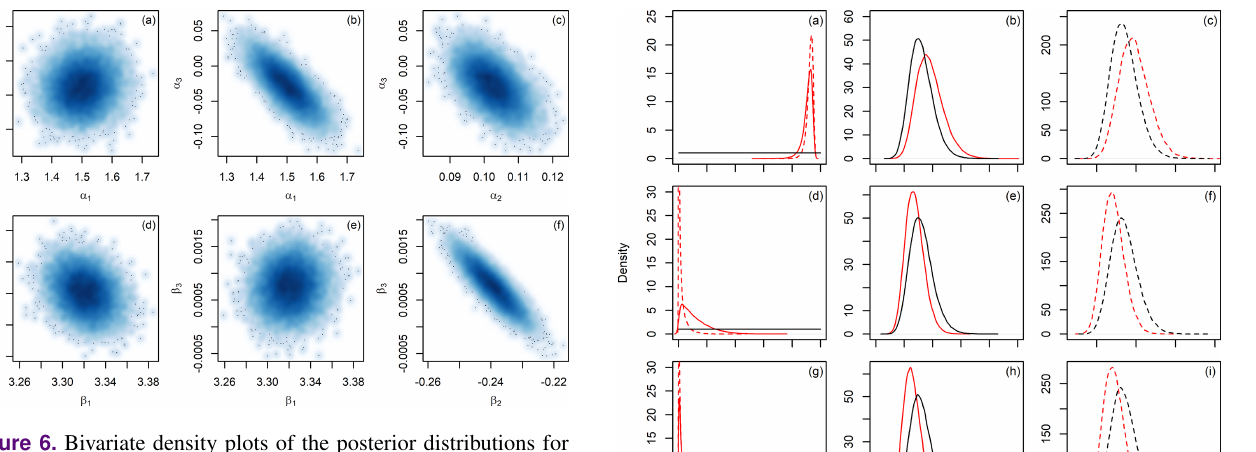
Figure 6. Bivariate density plots of the posterior distributions for Oridorsalis umbonatus Mg / Ca (a–c) and Cibicidoides sp. δ 18 O (d– f) proxy model parameters from the site 806 analysis.